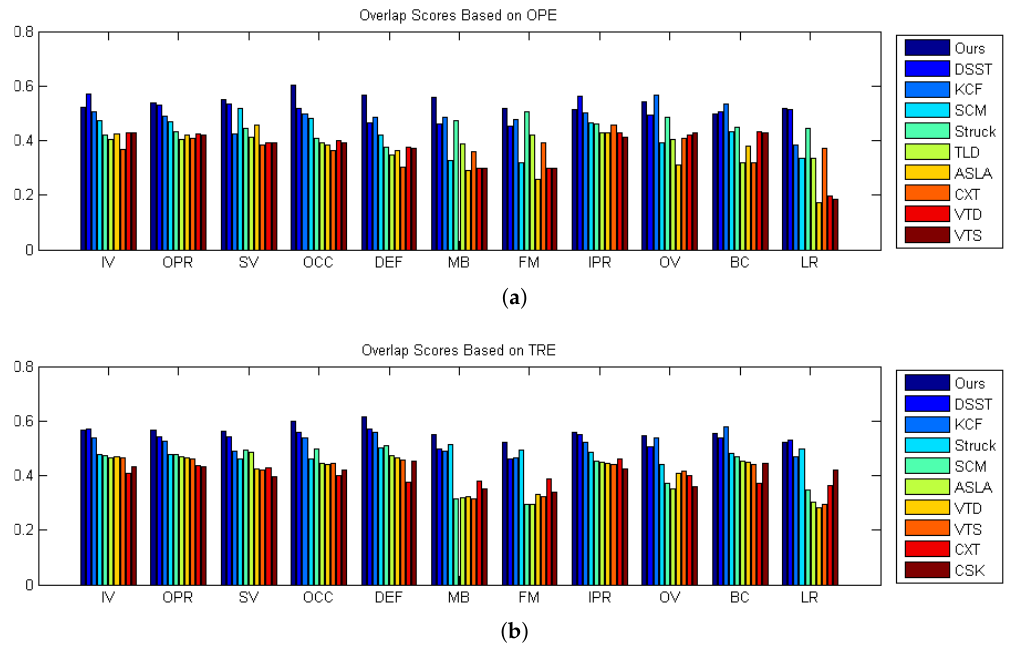
Figure 8. The performance of different attributes. ( a ) Performance scores based on OPE; ( b ) performance scores based on TRE. The meanings of the abbreviations, labeled on the horizontal axis, are list following: IV: illumination variation, SV: scale variation, OCC: occlusion, DEF: